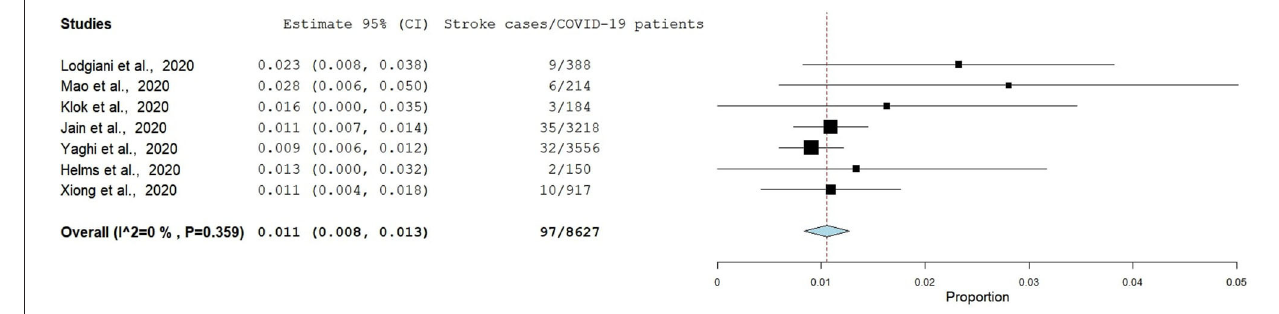
FIGURE 2 | The forest plot of the pooled frequency of stroke among COVID-19 patients.